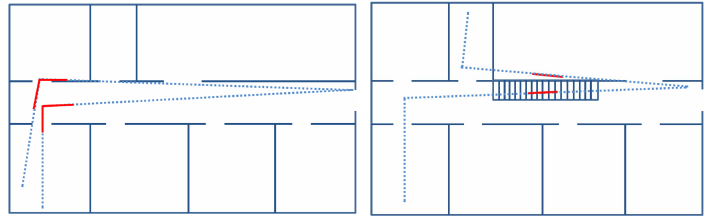
Figure 5. Schematic drifted trajectory including corners ( left ) and stairs ( right